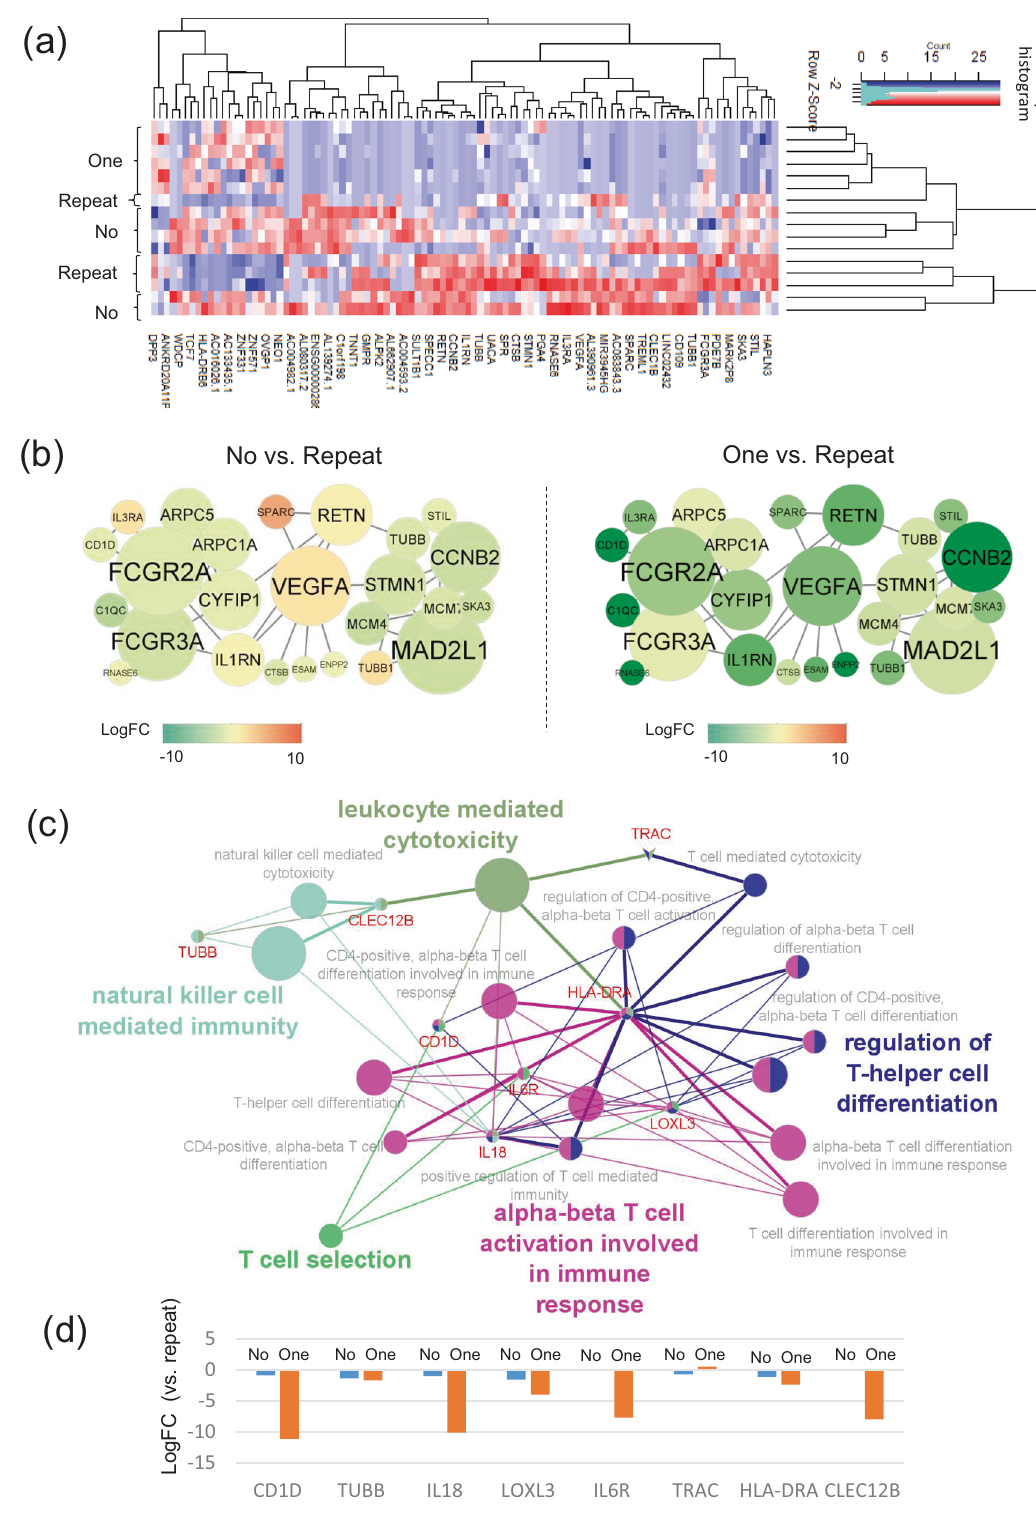
Category de fi nition and preemptive treatment for CMV reactivation . CMV reactivation was monitored weekly after neutrophil engraftment using a CMV antigenemia assay by the C10/11 method 7,62 . Reactivation was de fi ned when ≥ 3 CMV antigenemia were detected. CMV reactivation was categorized into three patterns: no reactivation, one sequential reactivation event, and repeated episodes even after CMV reactivation was once resolved by ganciclovir treatment. The recipients were categorized according to donor CMV serostatus (positive vs. negative) and/or the CMV-reactivation pattern (no vs. one vs. repeated).